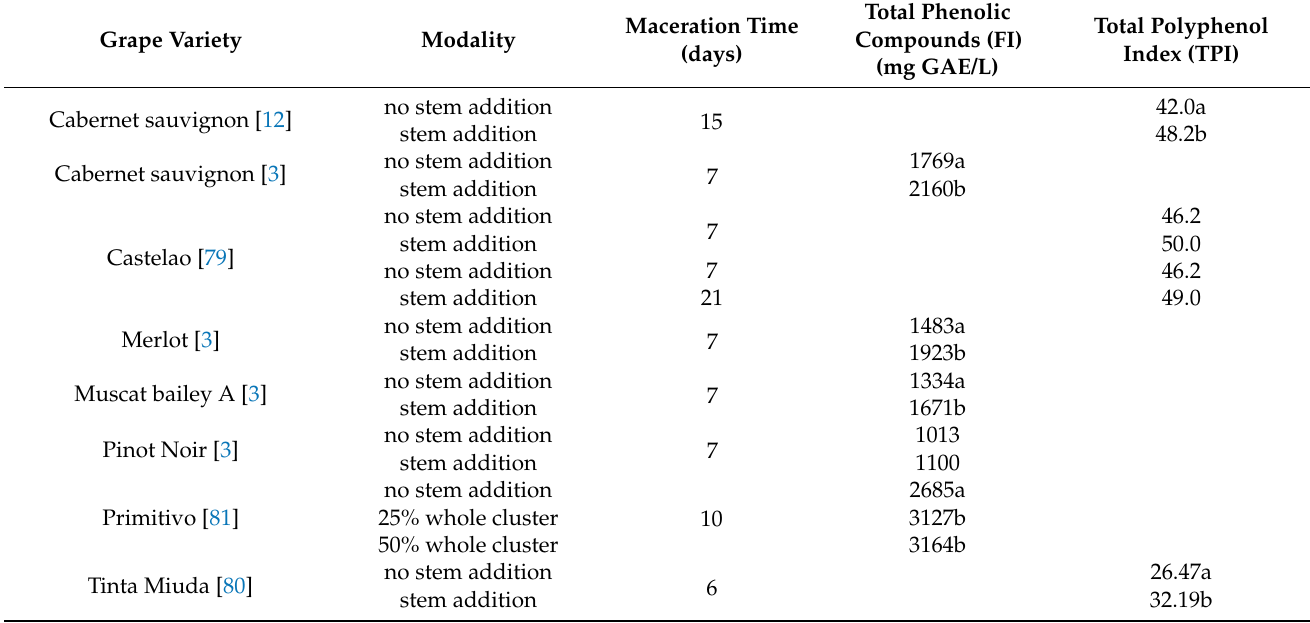
Table 15. Total polyphenol compounds in wine made with and without stem addition (for each study, different letters indicate significant statistical